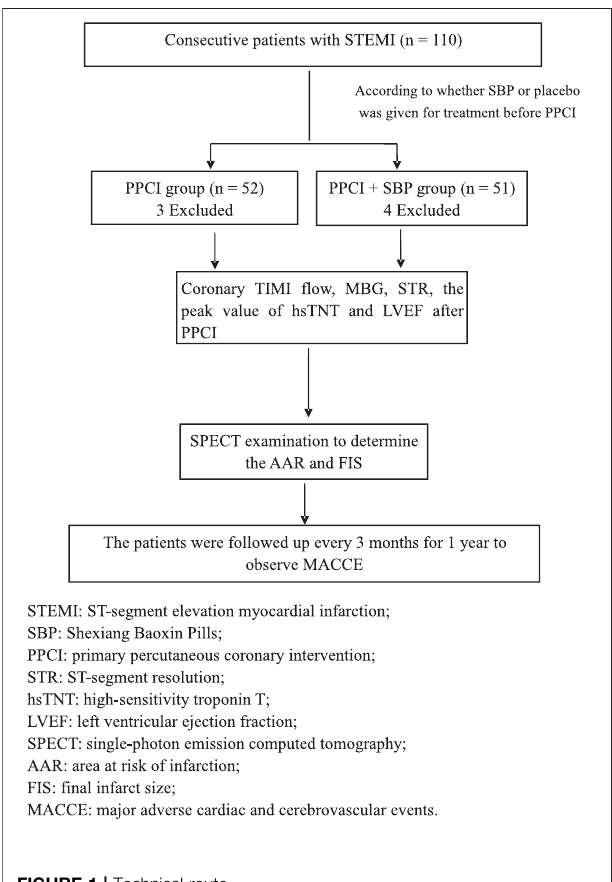
FIGURE 1 | Technical